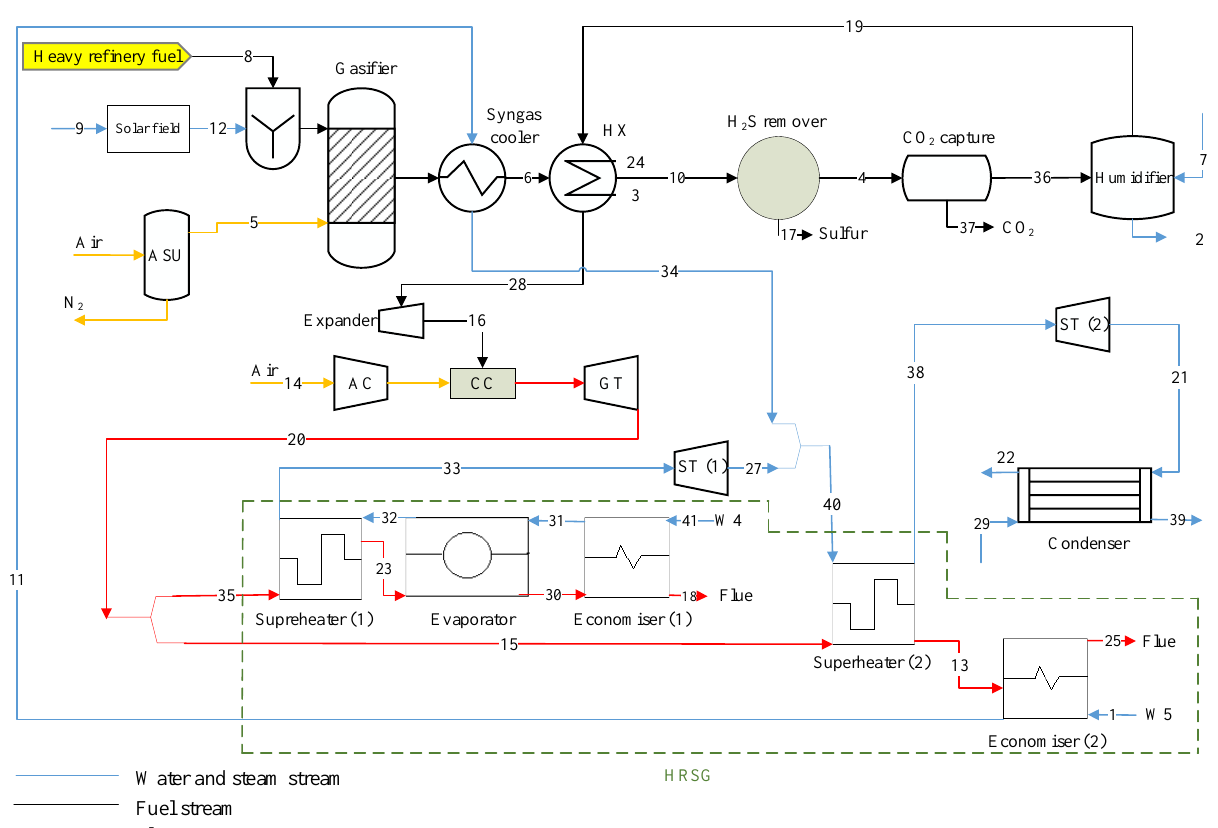
Figure 1. Schematic diagram of the proposed integrated solar-gasification cycle (ISGC) system (this diagram is adapted from Ref. [17]). AC: Air compressor; CC: Combustion chamber; HRSG: Heat recovery steam generator; GT: Gas turbine; ST: steam turbine.